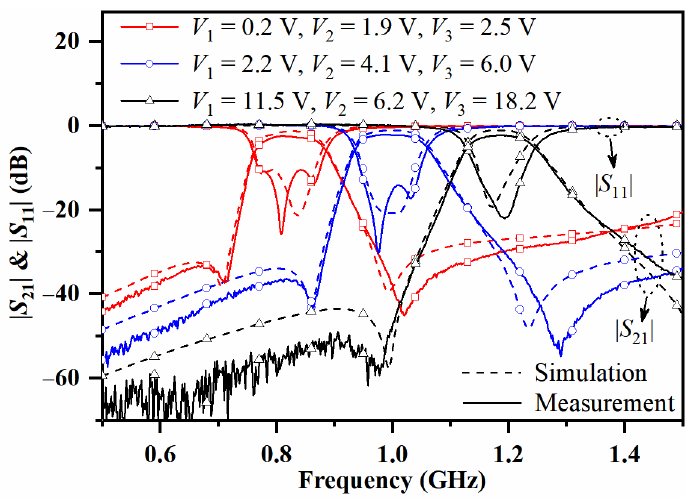
Figure 12. Simulated and measured S parameters for the proposed filter in on-state.